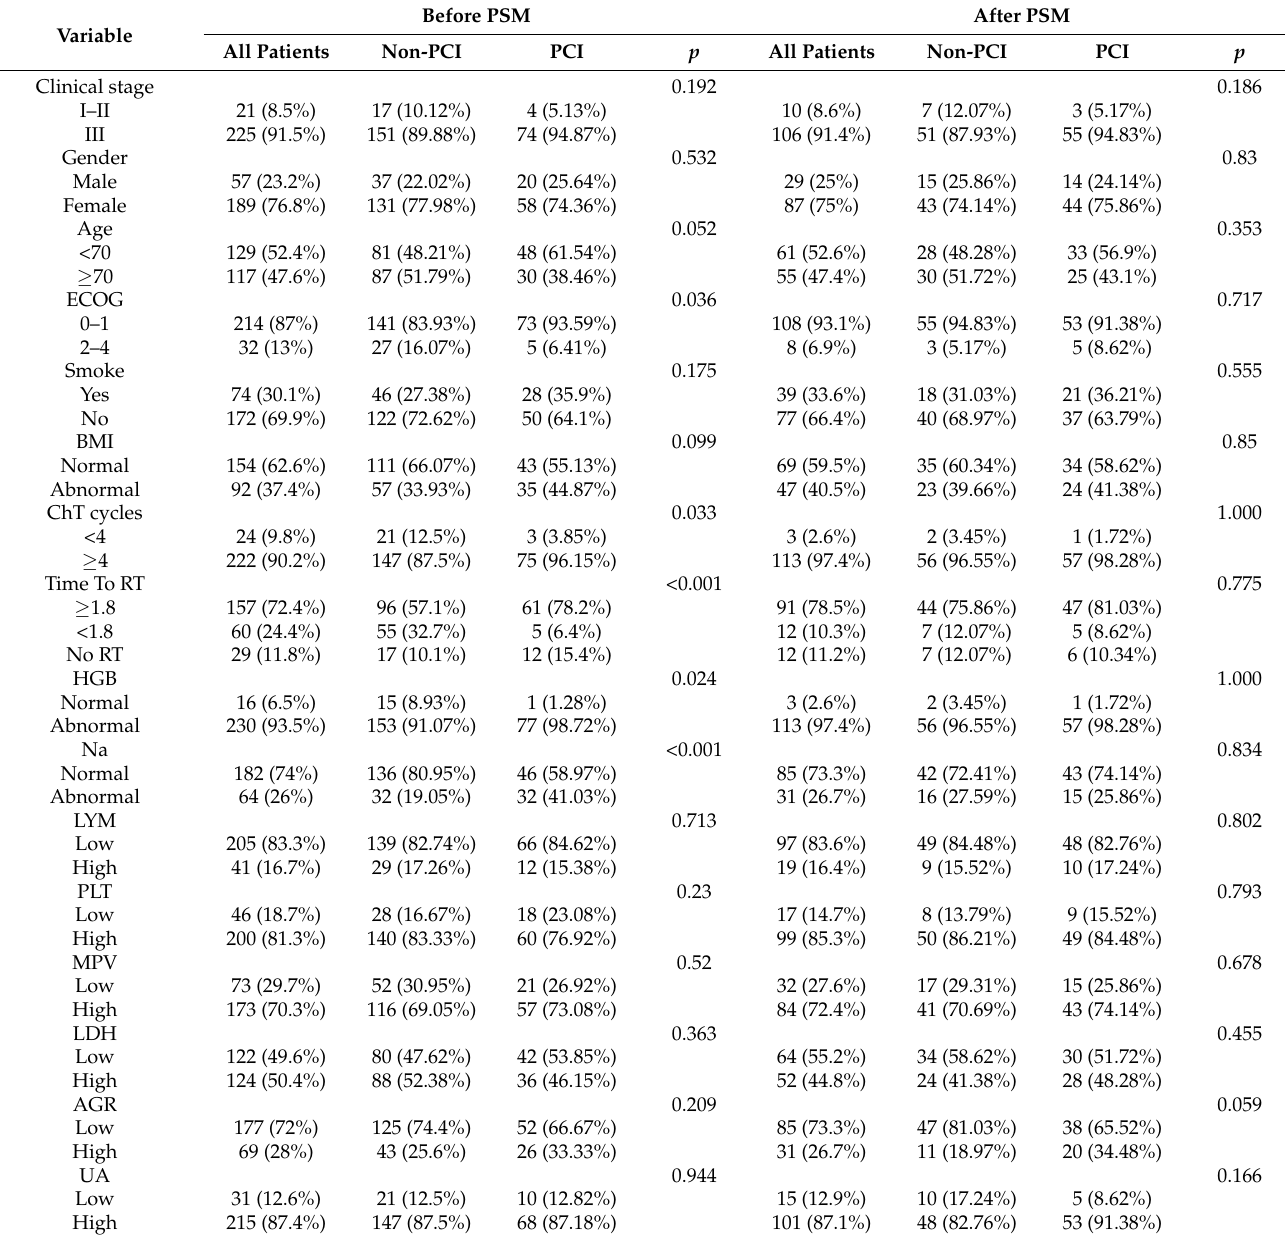
Table 1. Patient characteristics before and after